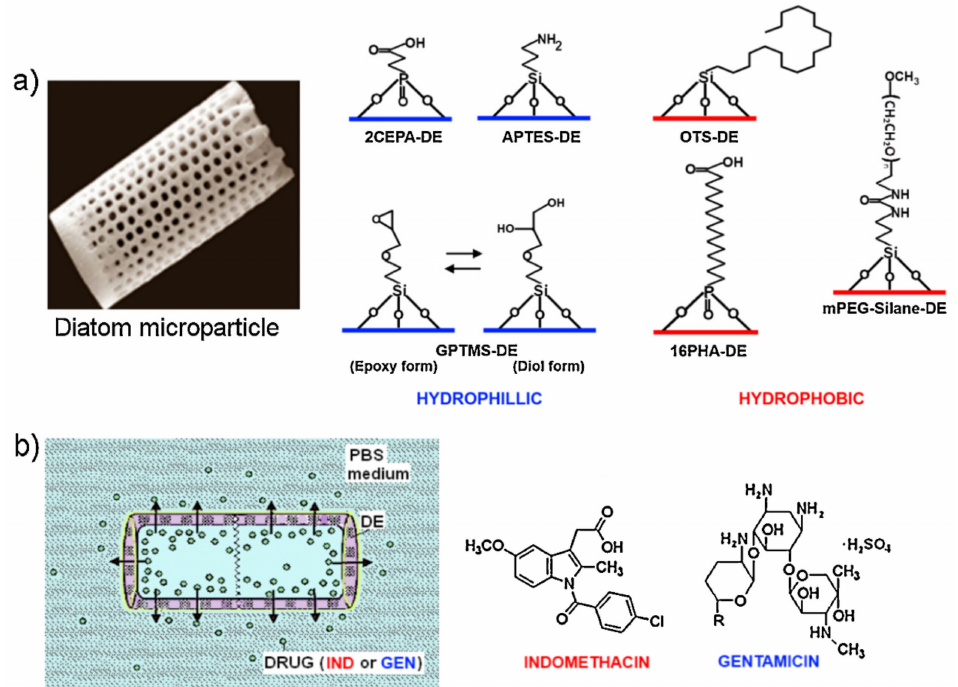
Figure 6. Chemical surface modification of DNPs. ( A ) Labeled siRNA-loaded DNPs and ( B ) label-free siRNA-loaded DNPs. Reproduced from [75], copyright (2017), with permission from John